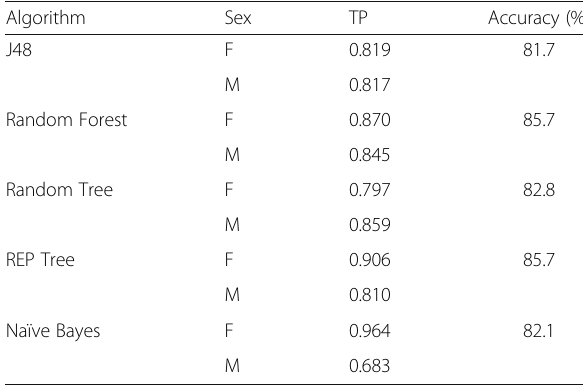
Table 7 Accuracy rates for sex determination through following algorithms by using toe lengths and toe length